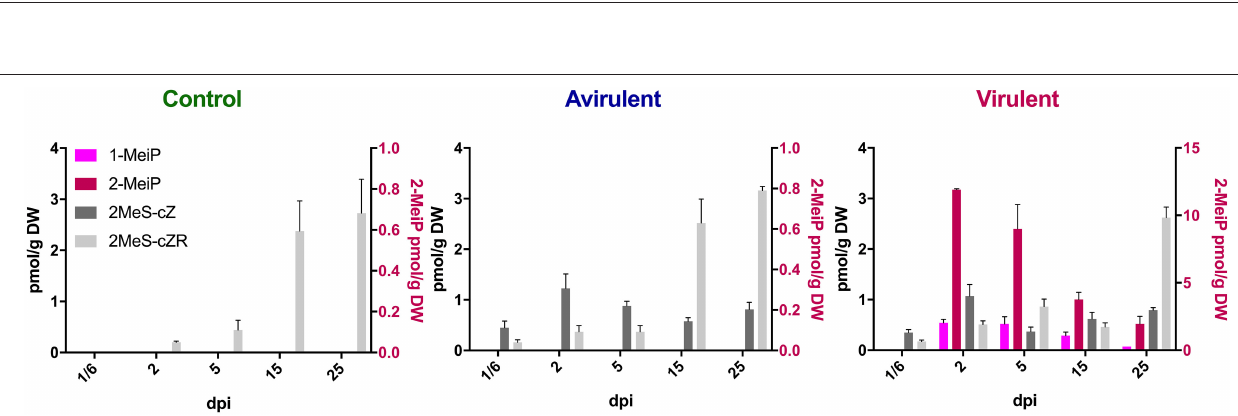
Frontiers in Plant Science |